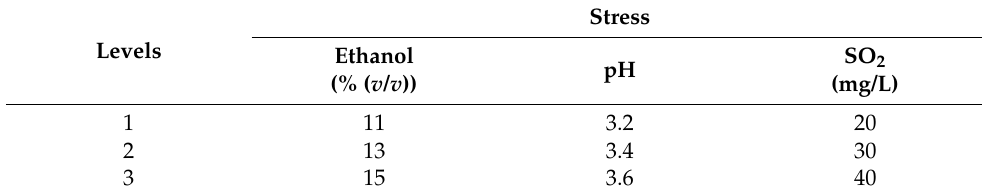
Table 1. The orthogonal experimental